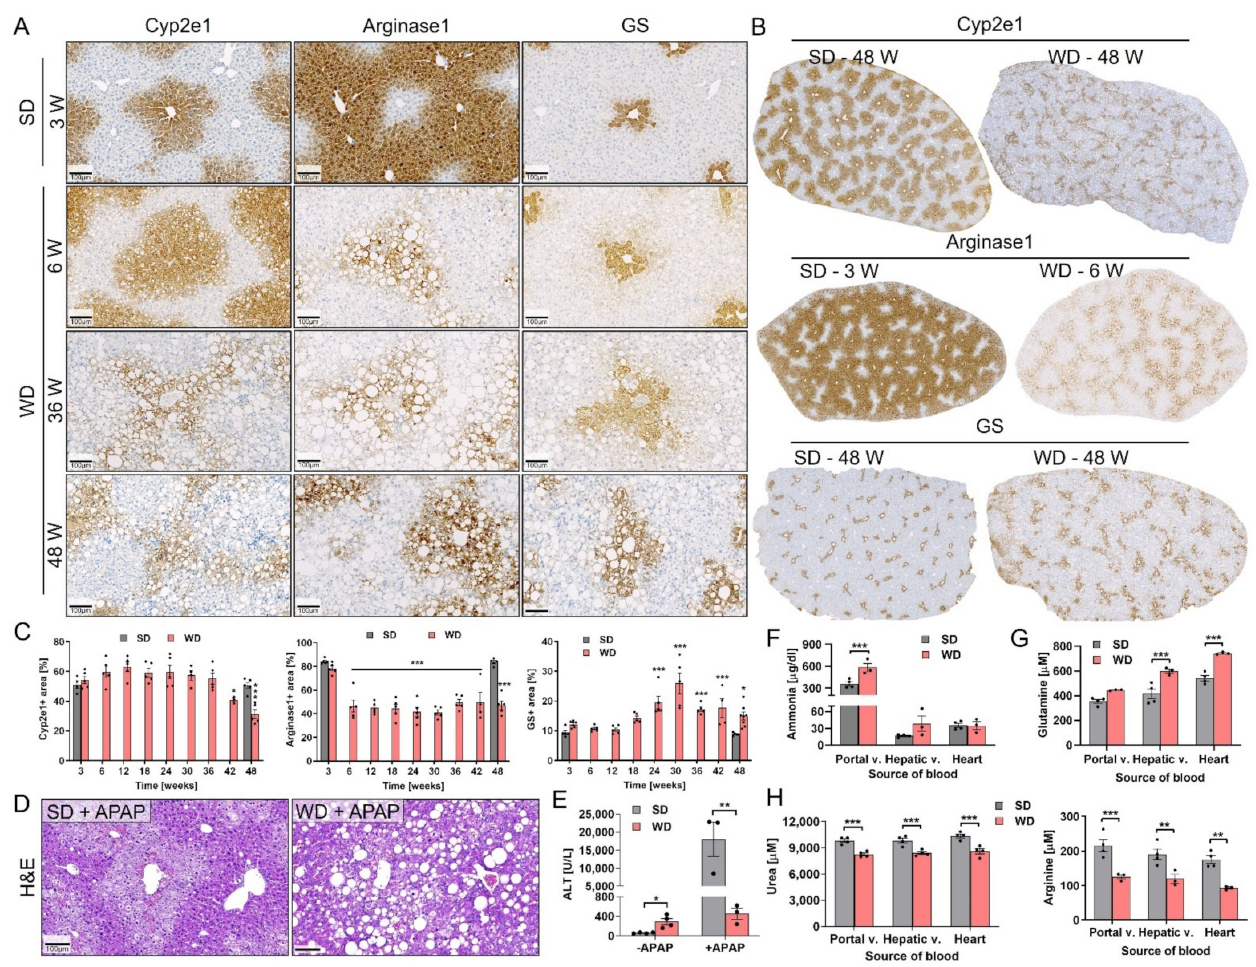
Figure 7. Lobular reorganization of metabolizing enzymes and functional consequences. ( A ) Reorganization of the pericentral enzymes Cyp2e1 and GS and the periportal/midzonal enzyme arginase1 in liver of WD-fed mice. ( B ) Decrease in Cyp2e1 (pericentral) and the arginase1 (periportal/midzonal) lobular regions and increase of the pericentral GS positive zone after WD feeding. ( C ) Quantification of the Cyp2e1, arginase1, and GS positive lobular areas in whole slide scans; data represent mean and standard errors of 3–8 mice per time point. *: p < 0.05; ***: p < 0.001 compared to SD week 3, Sidak’s multiple comparisons test; data of individual mice are illustrated by dots. ( D , E ) Hepatotoxicity of 300 mg/kg APAP in